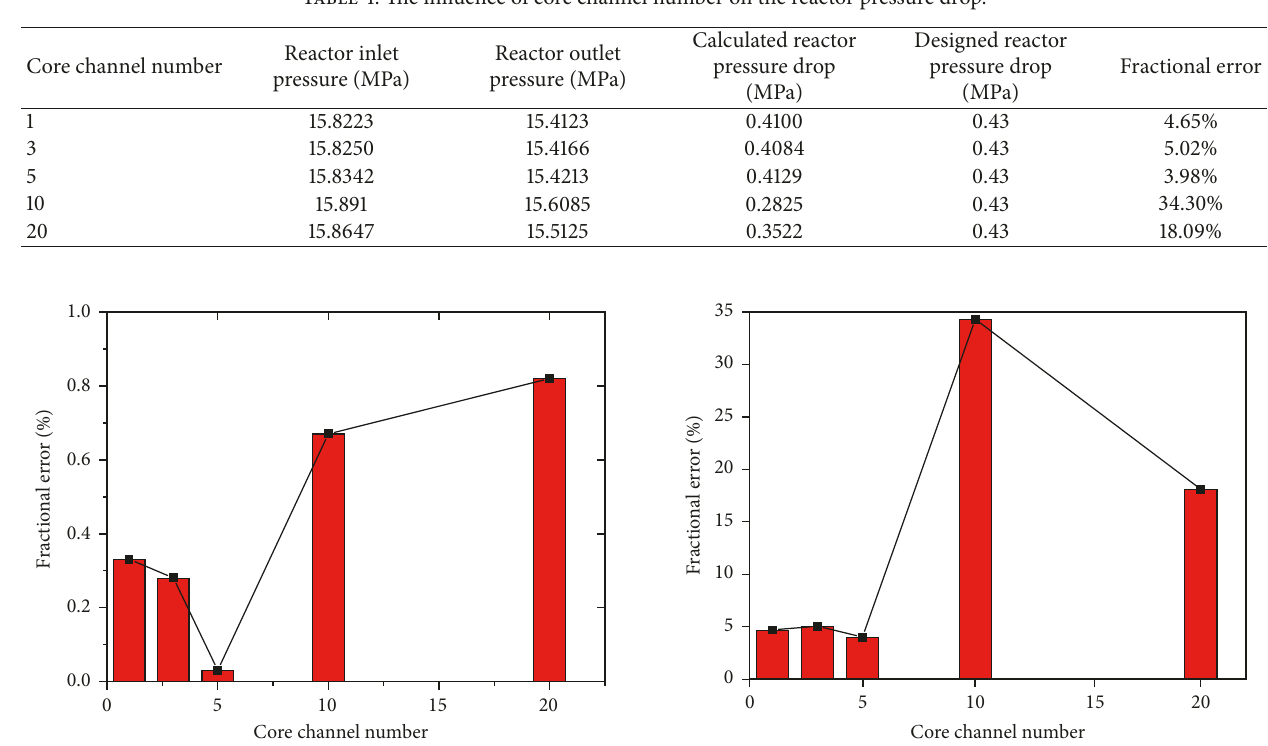
Figure 6: The influence of core channel number on the fractional error between calculated and designed coolant temperature varia- tion.